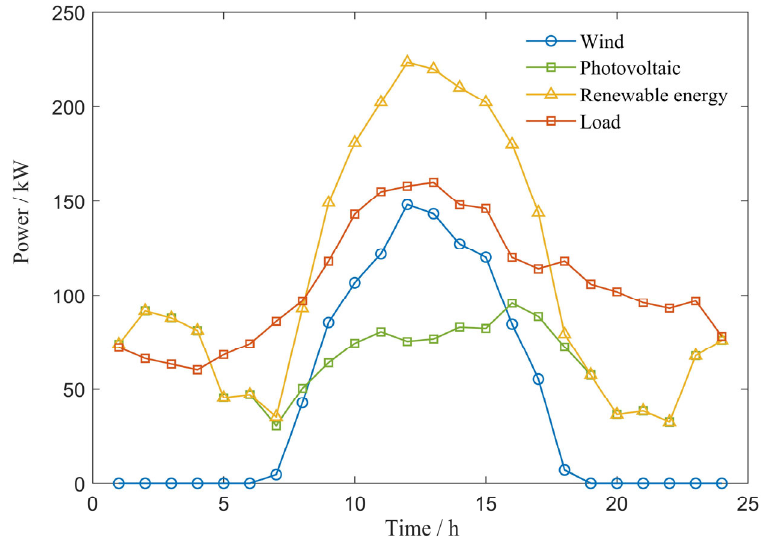
Figure 7. Joint distribution scenario.